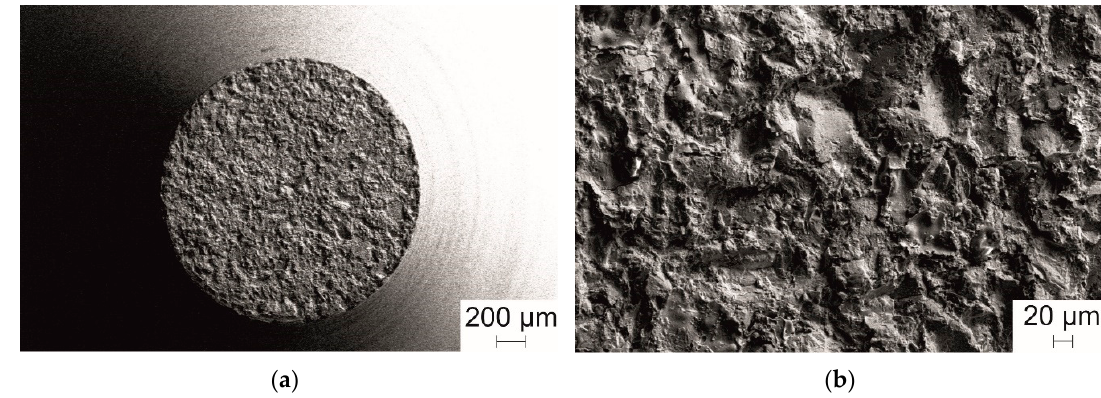
Figure 10. General view of the flat end of the pin after the bonding strength test ( a ); morphology of the pin surface indicating rupture along the coating/substrate interface ( b